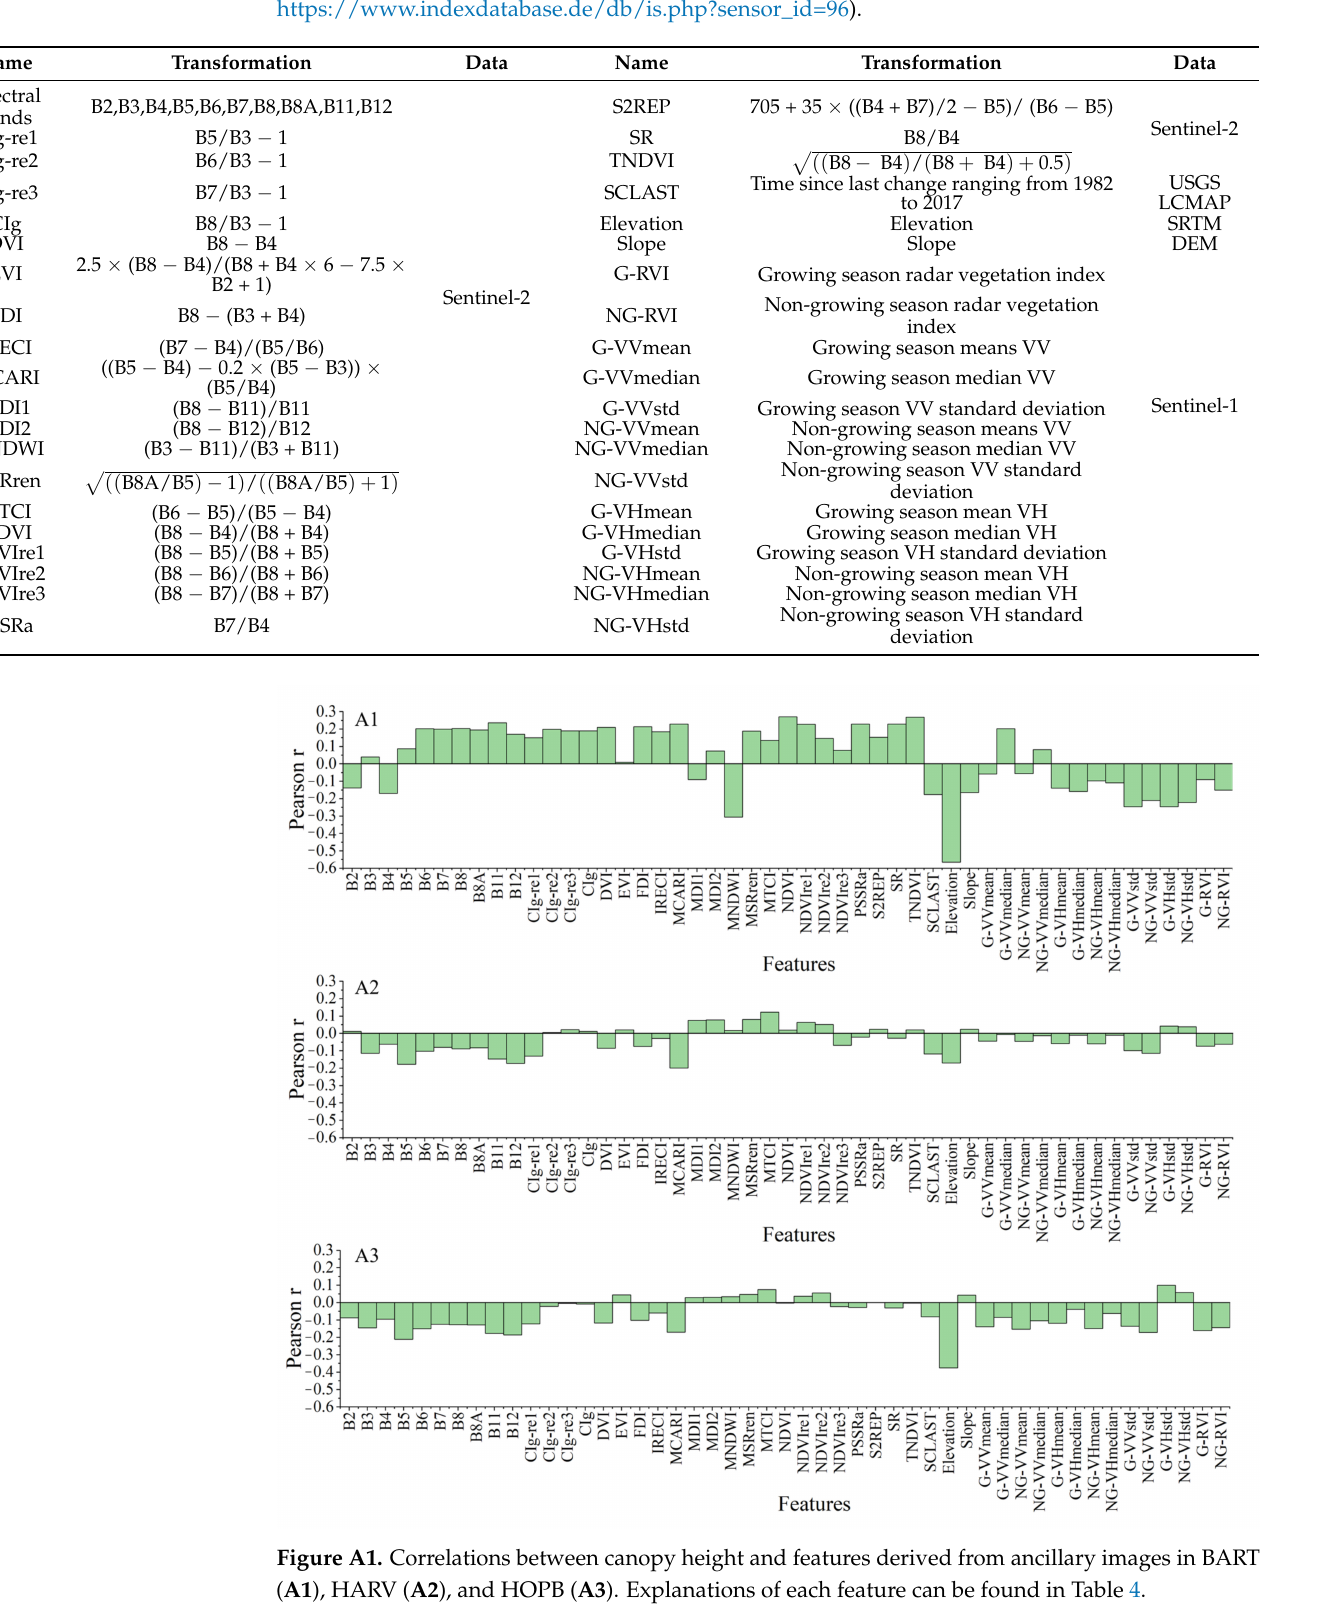
Table A2. The features were extracted from Sentinel-1 and-2 and other datasets for modeling canopy height by RF. B1-12 corresponds to the band of Sentinel-1 datasets in which VV and VH are bands in Sentinel-2. Details of derivative features can be found in the index database (URL: